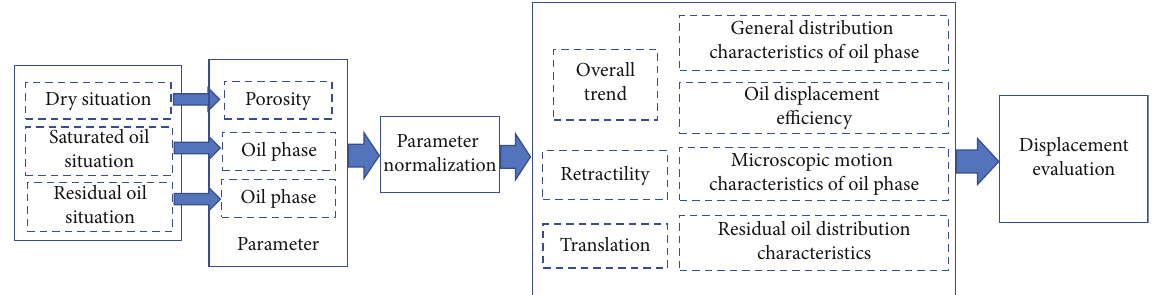
Figure 6: Water fl ooding description